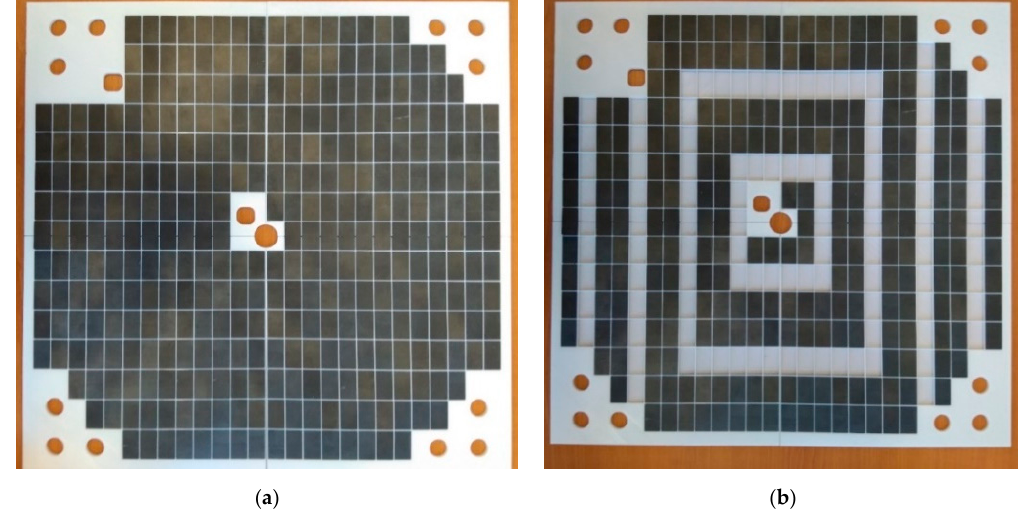
Figure 4. Practical alternatives of reconfigurable magnetic shielding (built form N92 Ferrite—25 × 14 × 2.5 [mm]). ( a ) full system shielding, ( b ) partial system shielding (rings).